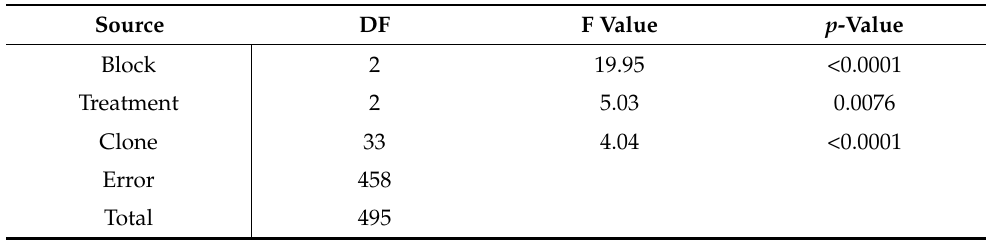
Table A4. ANOVA for mean stem volume (mm 3 ) of balsam poplar in 2019 at the end-pit lake (treat- ment 1 = 25 selected tolerant clones, treatment 2 = 10 selected control clones, treatment 3 = Stream 1 vegetative lot